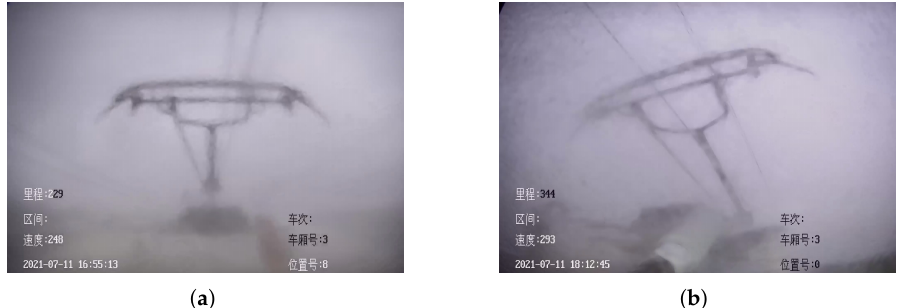
Figure 5. Blurred HSC imaging caused by rainwater. ( a ) HSR-A. ( b ) HSR-B.